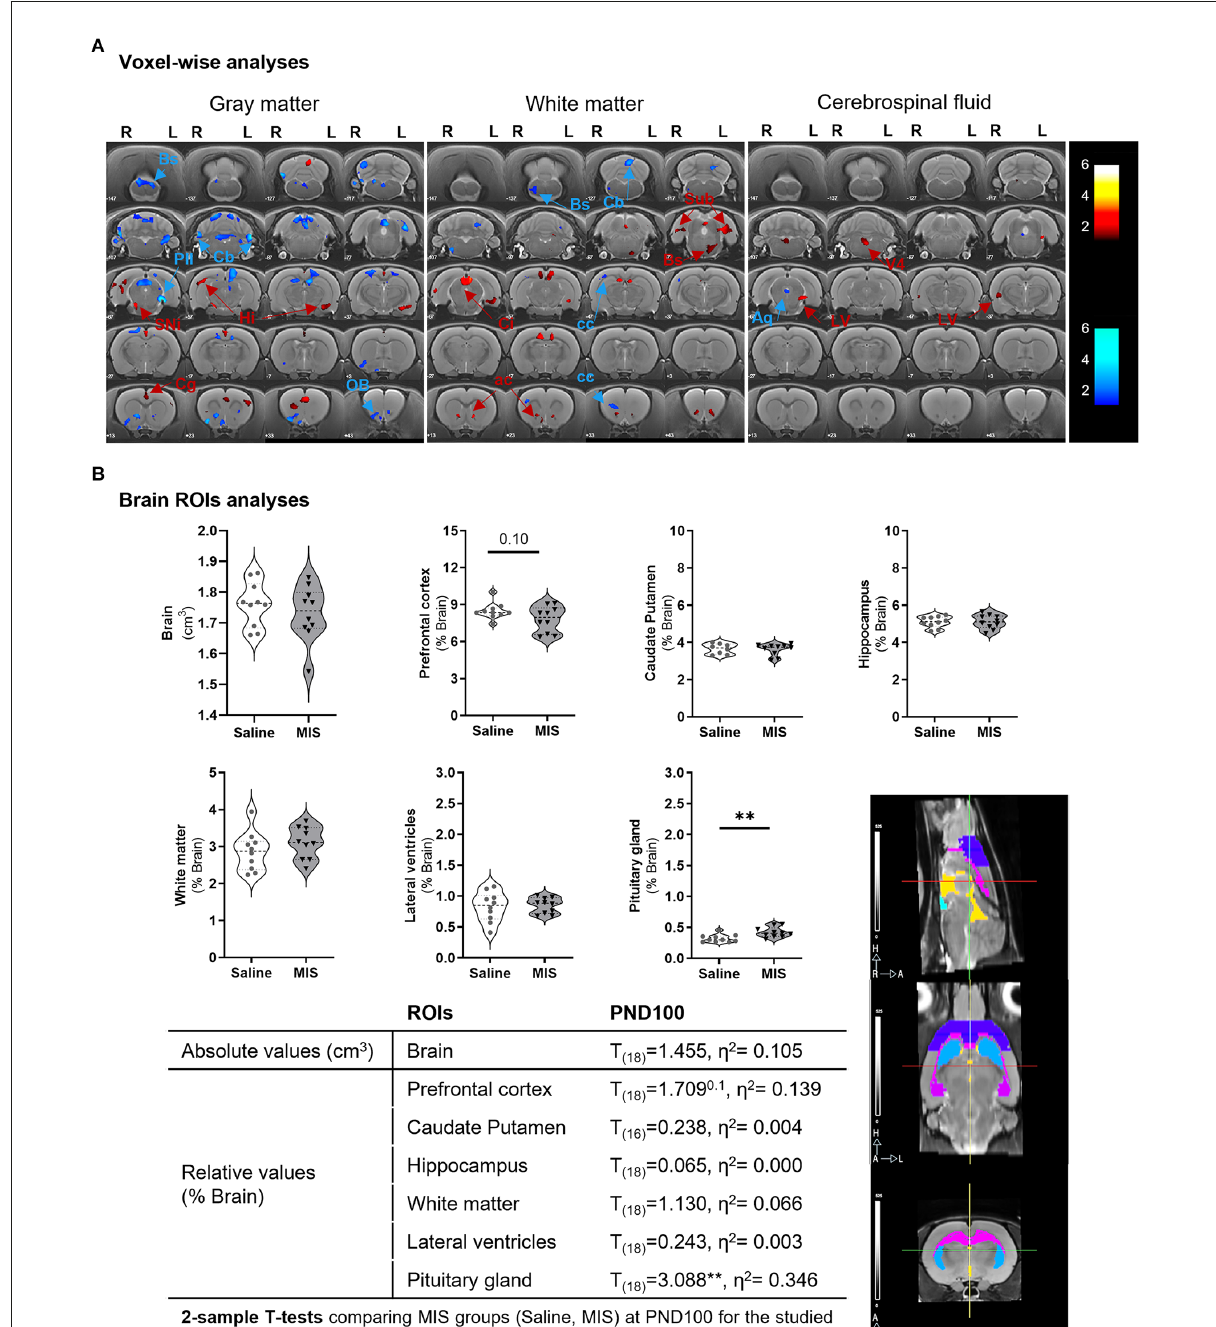
FIGURE3 MorphometricandvolumetricdifferencesbetweenSalineandMISadultfemalesevaluatedbyMRI. (A)Voxel-basedmorphometry(VBM)analyses in gray matter (left), white matter (middle), and cerebrospinal fluid (right). Results are shown in T -maps overlaid on a T2-MR template showing MIS phenotypic effect. T -values are represented by color bars showing enlargements (warm) or shrinkages (cold) in both left (L) and right (R) hemispheres. ROIs: AA, amygdalar hit; ac, anterior commisure; AQ, cerebral aqueduct; Bs, brainstem; Cb, cerebellum; cc, corpus callosum; Cg, cingulate cortex; Ci, colliculus; Hi, hippocampus; LV, lateral ventricle; OB, olfactory bulb; Pil, posterior intralaminar thalamic nucleus; Rs, retrosplenial cortex; Sin, substantia nigra; Sub, subiculum; V4, fourth ventricle. (B) ROIs analyses : Violin plots showing global and regional brain volume differences between MIS and Saline groups obtained via 2-sample T -test analyses ( p = 0.10, ∗∗ p < 0.01). The table shows MIS-related volumetric differences between Saline and MIS offspring in adulthood. A graphical representation of the studied ROIs (prefrontal cortex -purple-, hippocampus -pink-, caudate putamen -blue-, lateral ventricles -yellow-, pituitary gland -aquamarine-) overlaid on a T2 MRI is shown in the lower right part of the